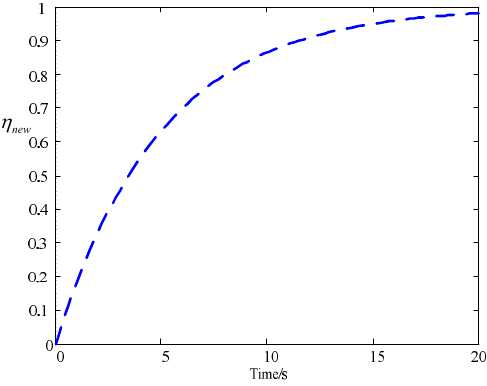
 with time.  with time. new new